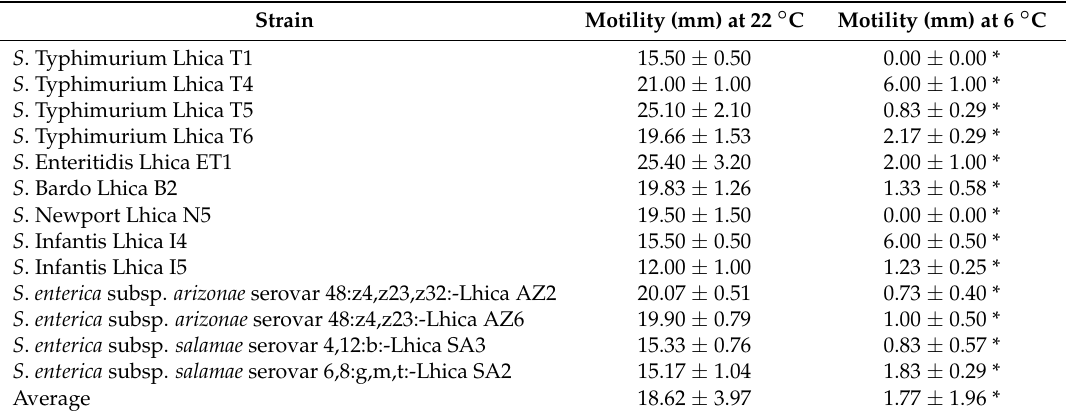
Table 2. Main motility (mm) of Salmonella strains tested in this study at 22 ◦ C and 6 ◦ C. Asterisks indicate significant differences ( p < 0.05) in each strain between the two